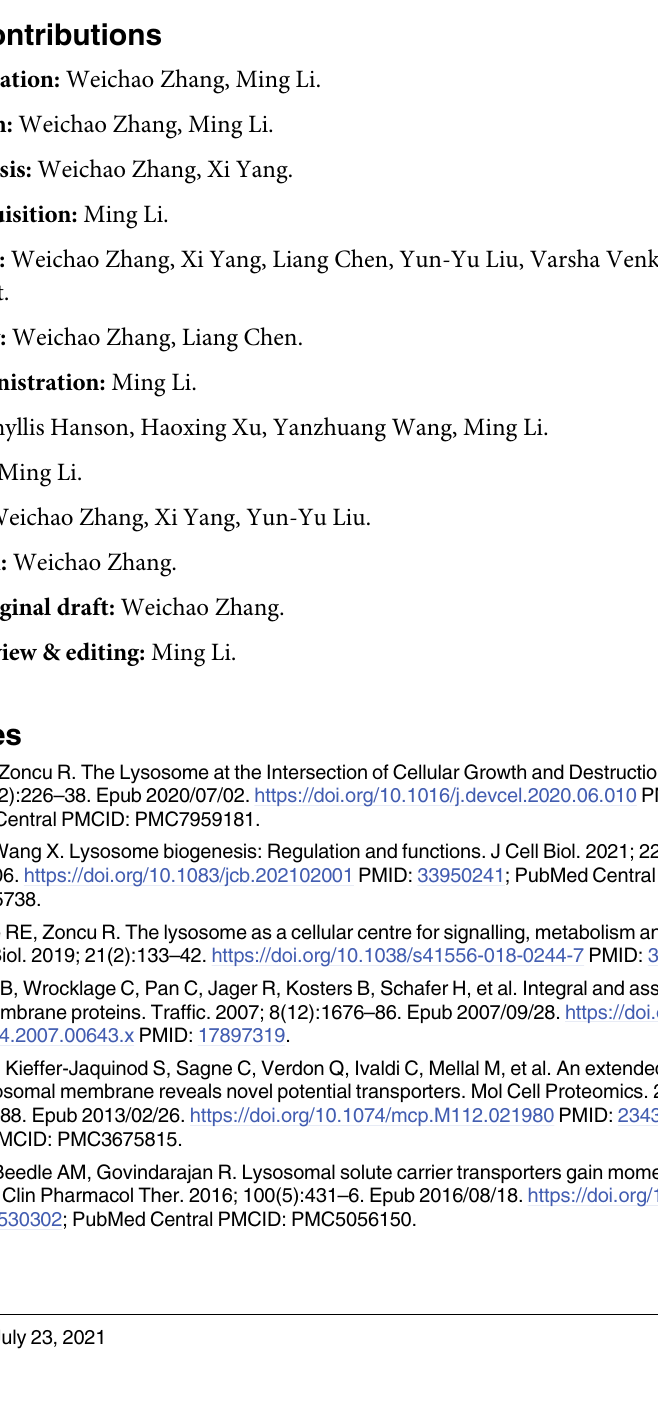
S1 Table. List of mammalian cell lines, yeast strains, and plasmids used in this study.